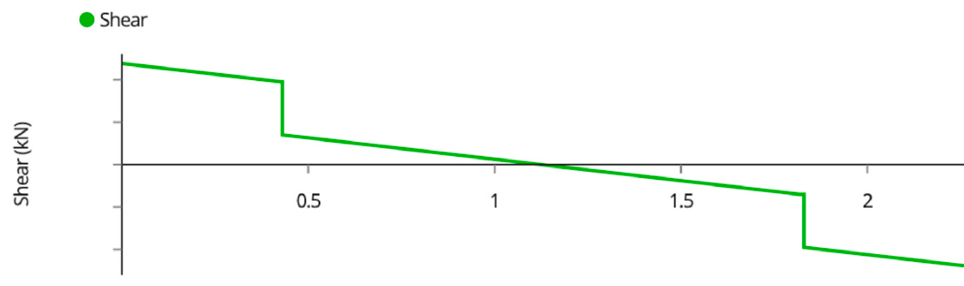
Figure A6. The 2 × 4 Weight Shear Force Diagram. The maximum shear force can be calculated using Equation (A7). 𝑉𝑚𝑎𝑥 (cid:2870)(cid:3400)(cid:2872)(cid:3024)(cid:3032)(cid:3036)(cid:3034)(cid:3035)(cid:3047) = 1.25 (cid:3436)𝑆𝑖𝑛𝑔𝑙𝑒 𝑀𝑜𝑑𝑢𝑙𝑒 𝑊𝑒𝑖𝑔ℎ𝑡 (cid:3397) 𝑜𝑤 (cid:2870)(cid:3400)(cid:2874) (cid:3400) 𝐿 2 (A7) The bending moment diagram is shown in Figure A7.